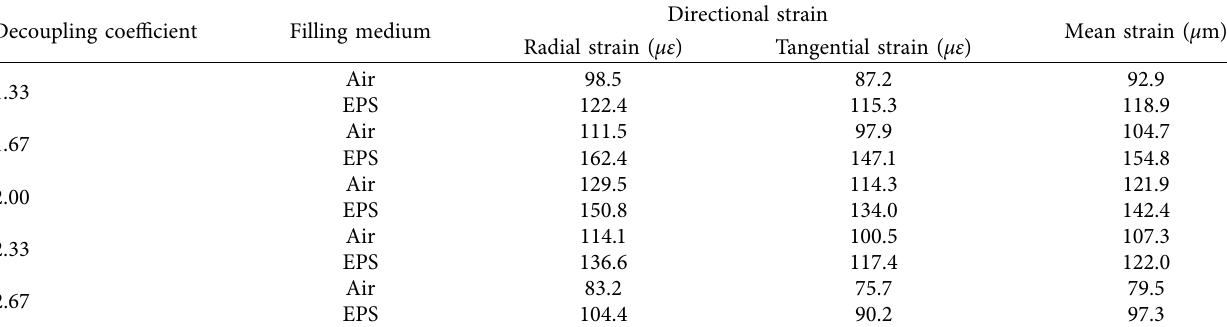
Table 6: Peak strains of specimens with different filler media.